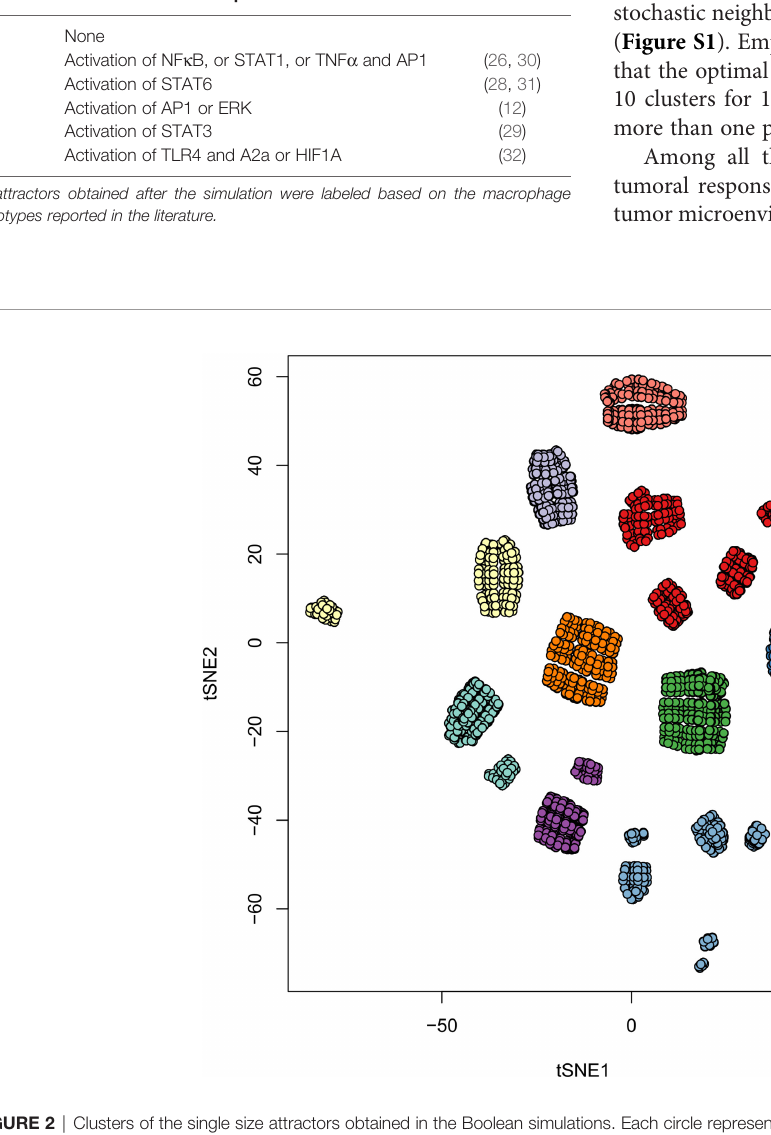
FIGURE 2 | Clusters of the single size attractors obtained in the Boolean simulations. Each circle represents a two-dimensional projection of one attractor, and the color represents a collection of attractors with similar phenotypes between them. The numbers associated with the clusters are explained in Table 1